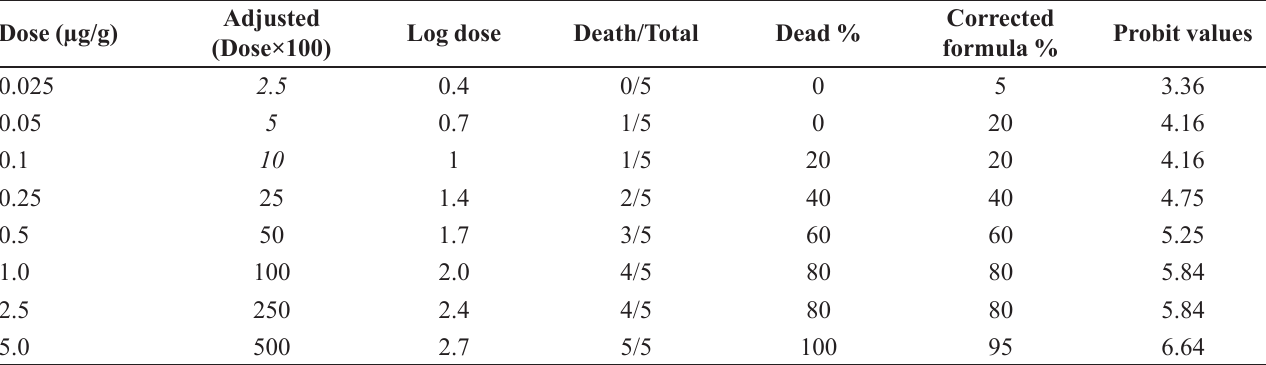
of Naja naja venom in mice receiving various doses of Naja naja venom by Miller and Tainter TABLE IV - Calculation of LD 50 method (n=5) Dose